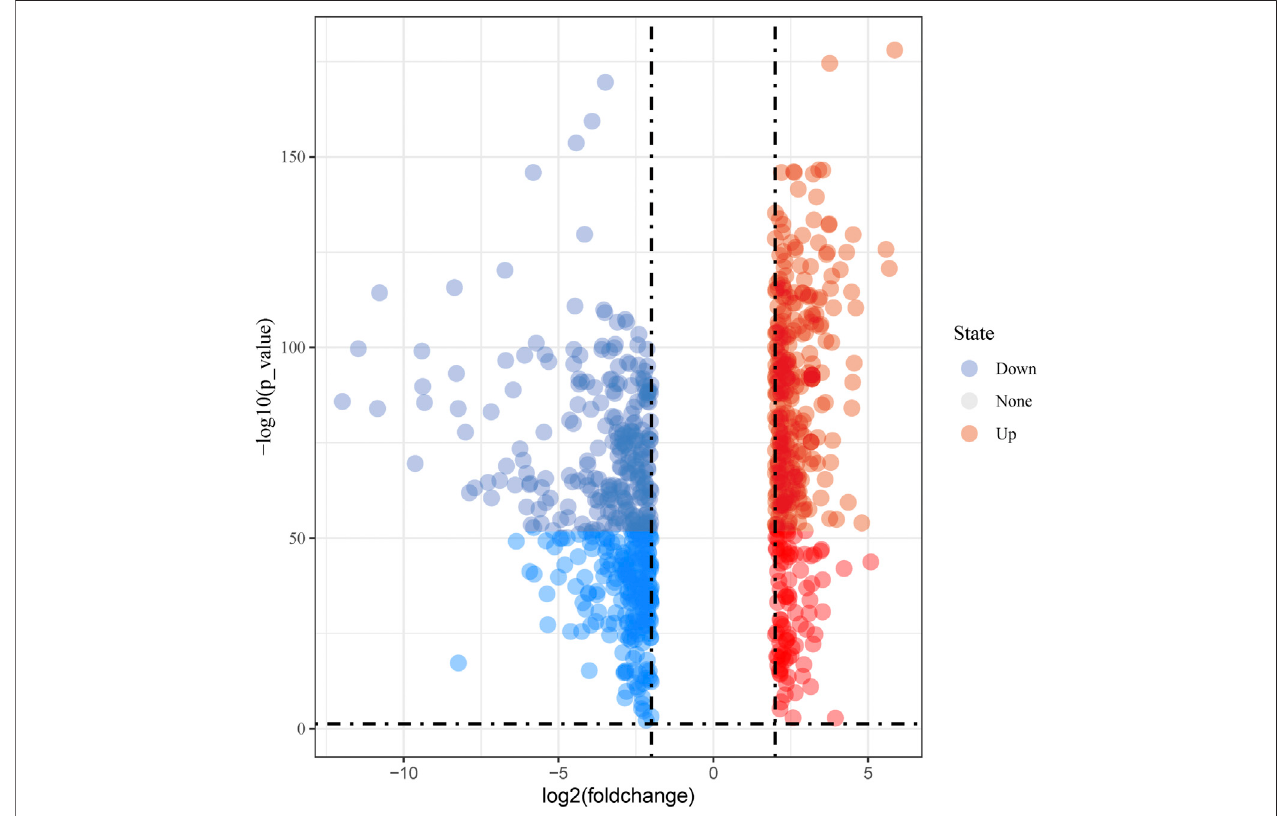
FIGURE 1 | Volcano plot of differentially expressed